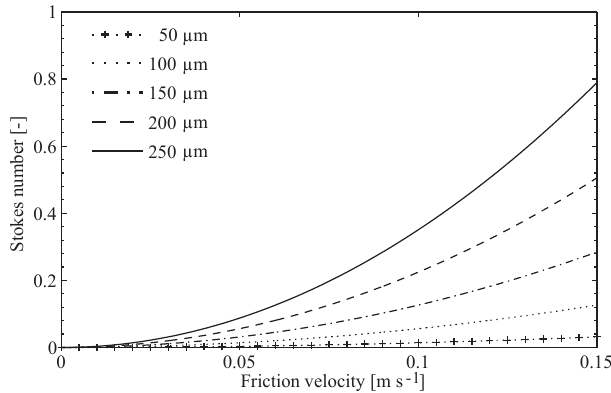
Figure 4. The Stokes number (Eq. 18) of different-sized quartz par- ticles in the near-boundary